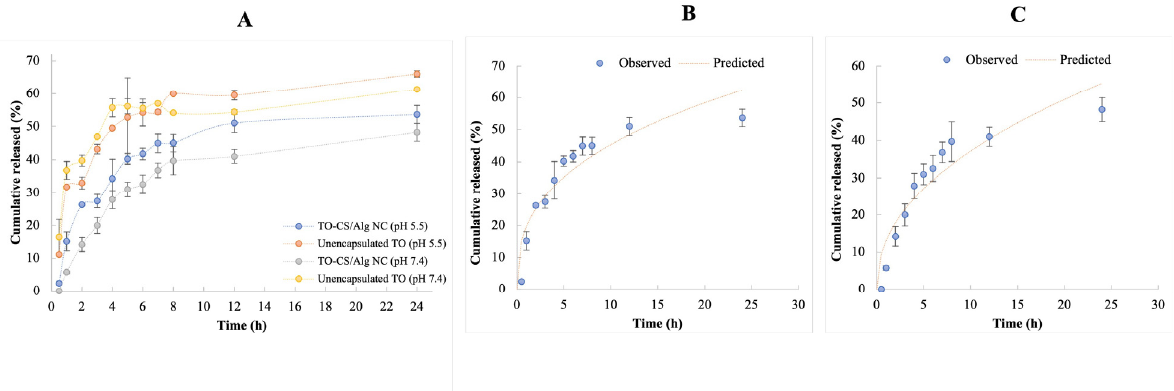
Figure 4. Release study showing ( A ) cumulative release of TO from unencapsulated TO and TO- CS/Alg-NCs in the release media, and nonlinear curve fitting to the experimental data using Korsmeyer–Peppas model in ( B ) pH 5.5 and ( C ) pH 7.4.